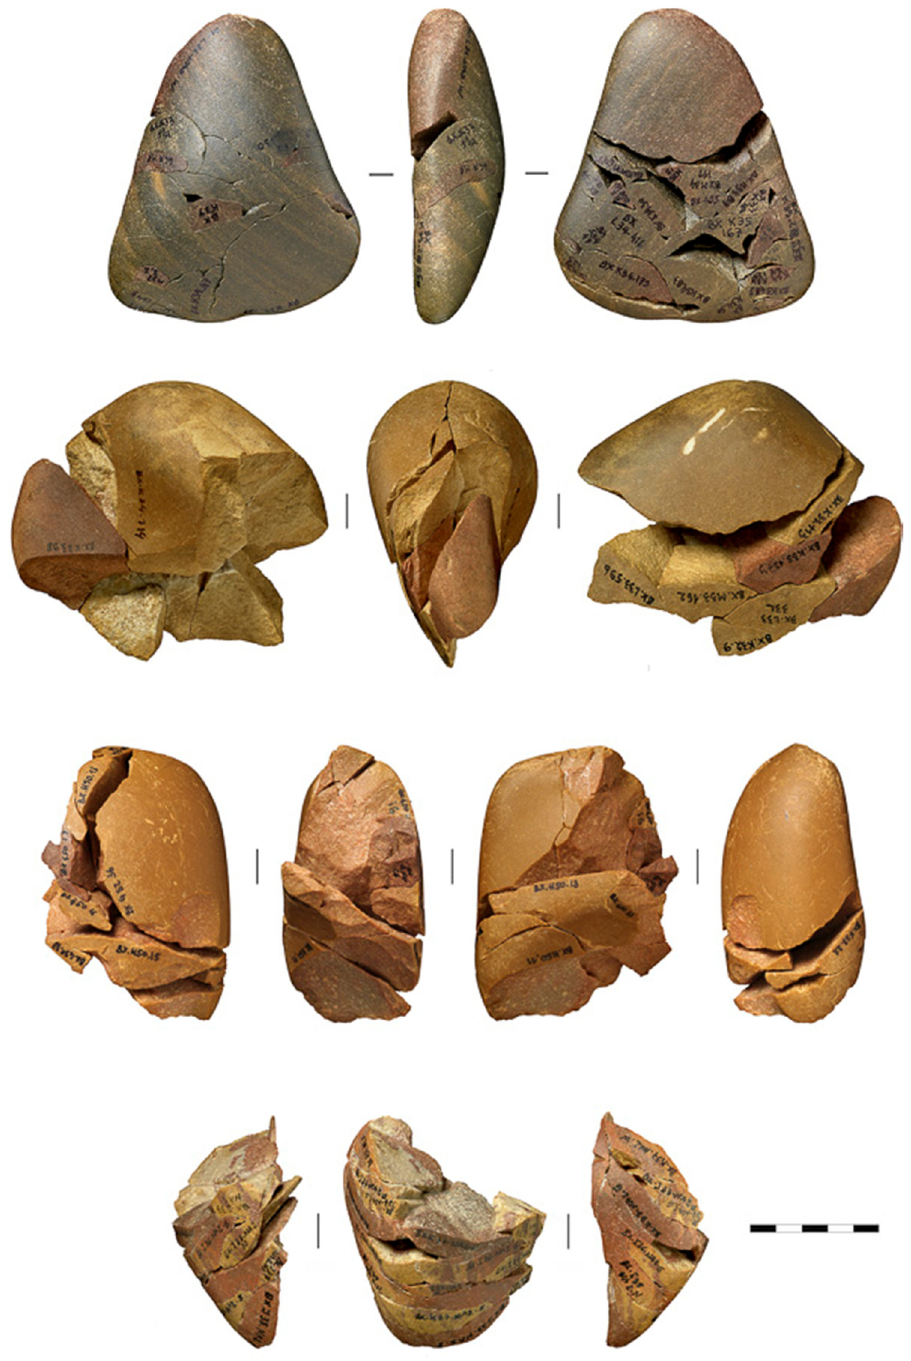
Figure 12: Barca do Xerez de Baixo: reconstructions of quartzite volumes used to produce fl akes, the desired end - products. Photo, J. P.